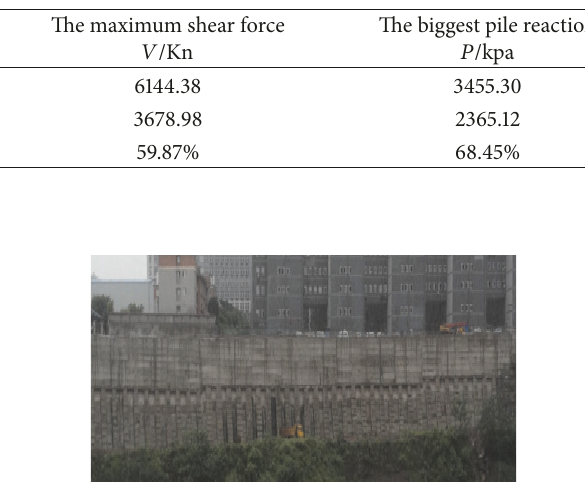
Figure 13: The self-balance retaining wall in light industrial zone